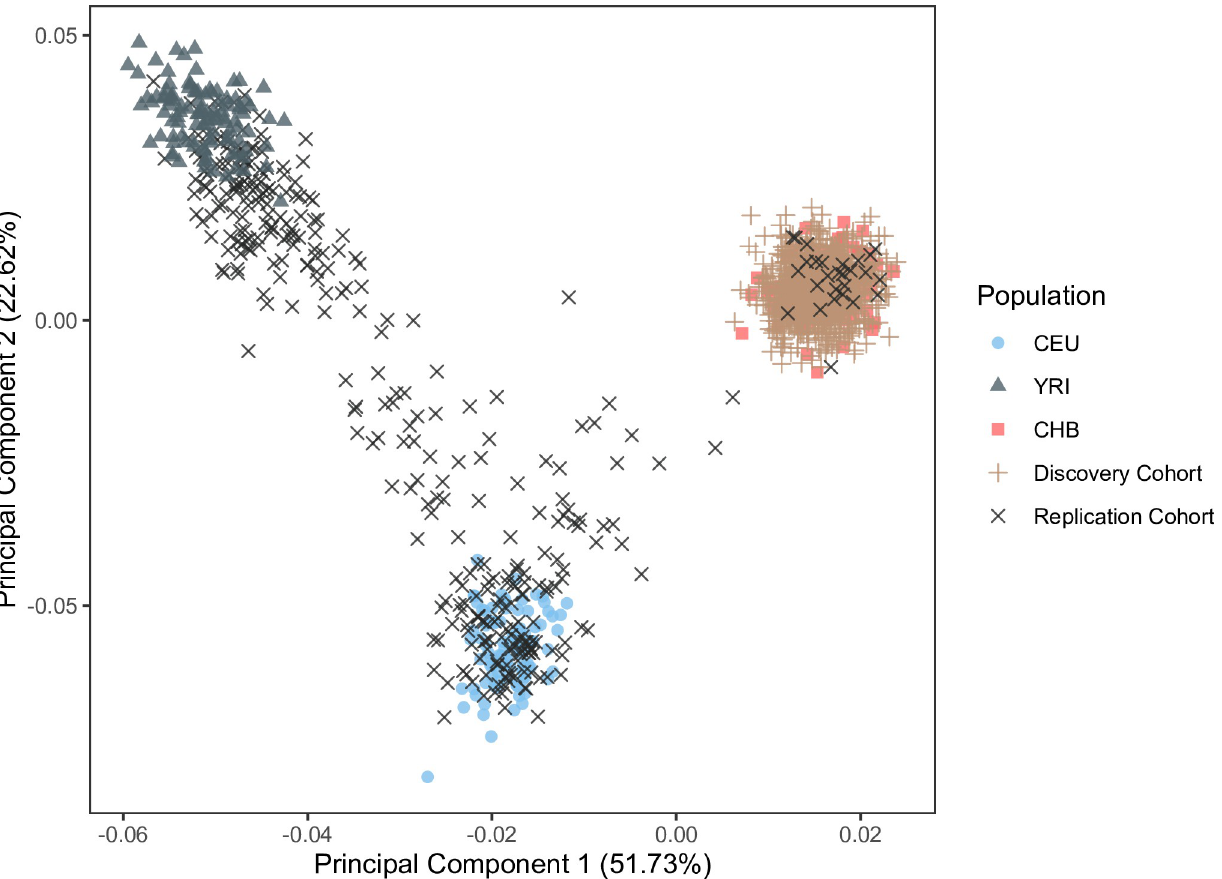
Fig 1. Population structure analysis reveals relative homogeneity of the discovery population (tan plus sign) compared to the validation population (black x) (p < 2.2x10 -16 ). Shown are the first two principal components calculated from all variants genotyped in both the discovery and validation cohorts. Representative populations from the 1000 Genomes Project: Han Chinese in Beijing (CHB, n = 97; red square), Utah residents with Northern and Western European ancestry from the CEPH collection (CEU, n = 86; blue circle), and Yoruba in Ibadan, Nigeria (YRI, n = 88; black triangle) are plotted for context. The discovery population overlapped with the CHB population (mean distance to CHB = 0.001, CEU = 0.07, YRI = 0.07).